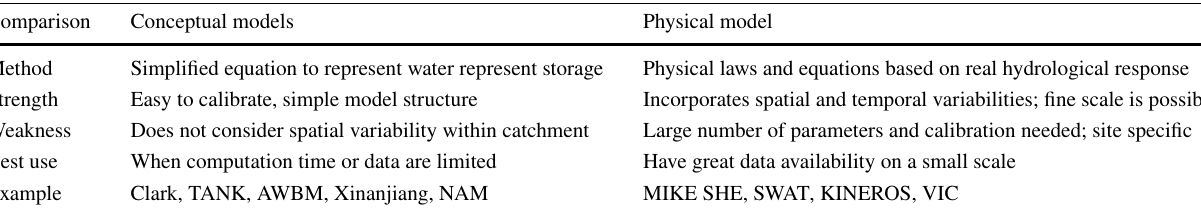
Table 1 Comparison of conceptual and physical